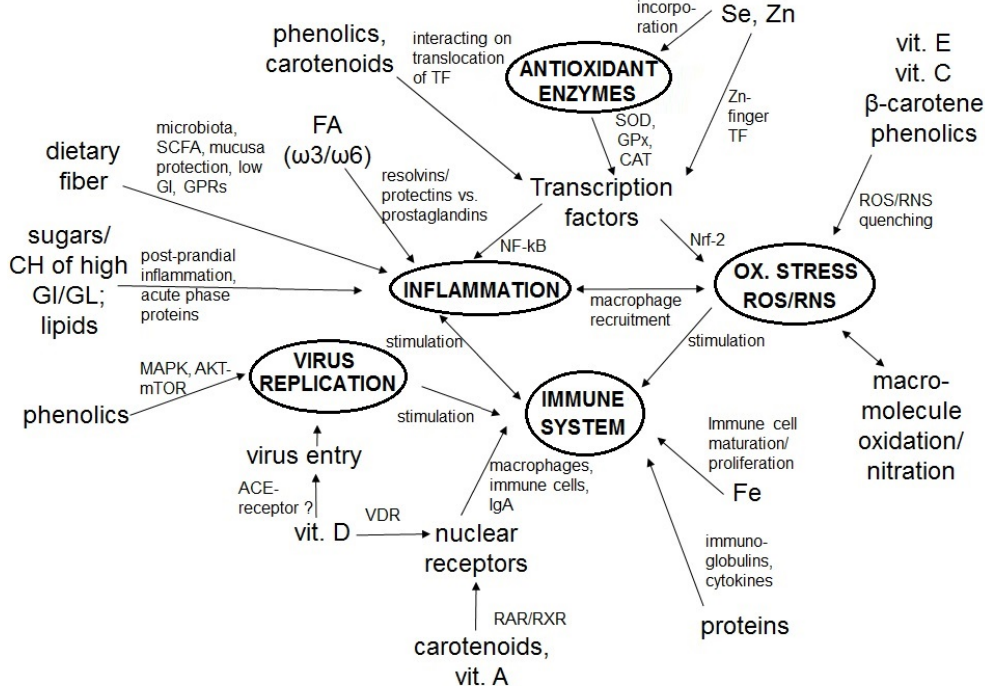
Figure 1. Schematic diagram showing interactions between selected dietary constituents, the immune system, and viral infection. Abbreviations: CH: carbohydrates; GALT: gut-associated lymphoid tissue; GPRs: G-protein-coupled receptors; FA: fatty acids; GI / GL: glycemic index / load; RAR / RXR: retinoic acid receptor / retinoid X receptor; SCFA: short-chain fatty acids; TF: transcription factors; VDR: vitamin D receptor. Table 2. Examples of dietary sources.